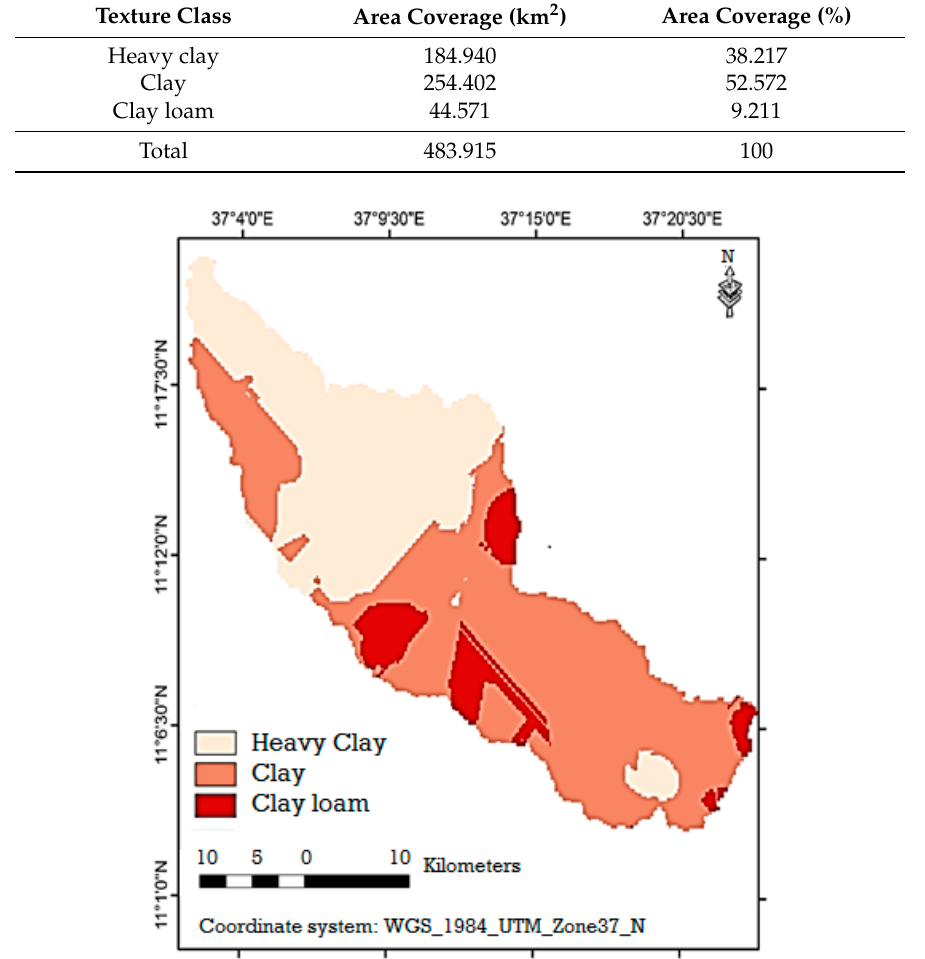
Figure 4. Predicted output surface for the combined soil particles (texture class).